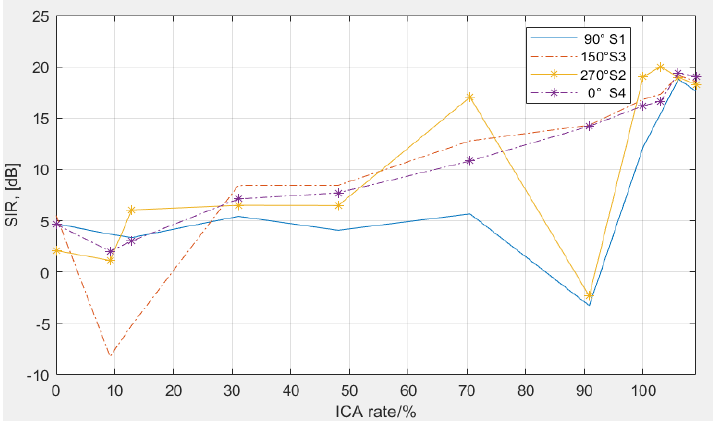
Figure 11. SIR improvement with separation under four sources in Room A.